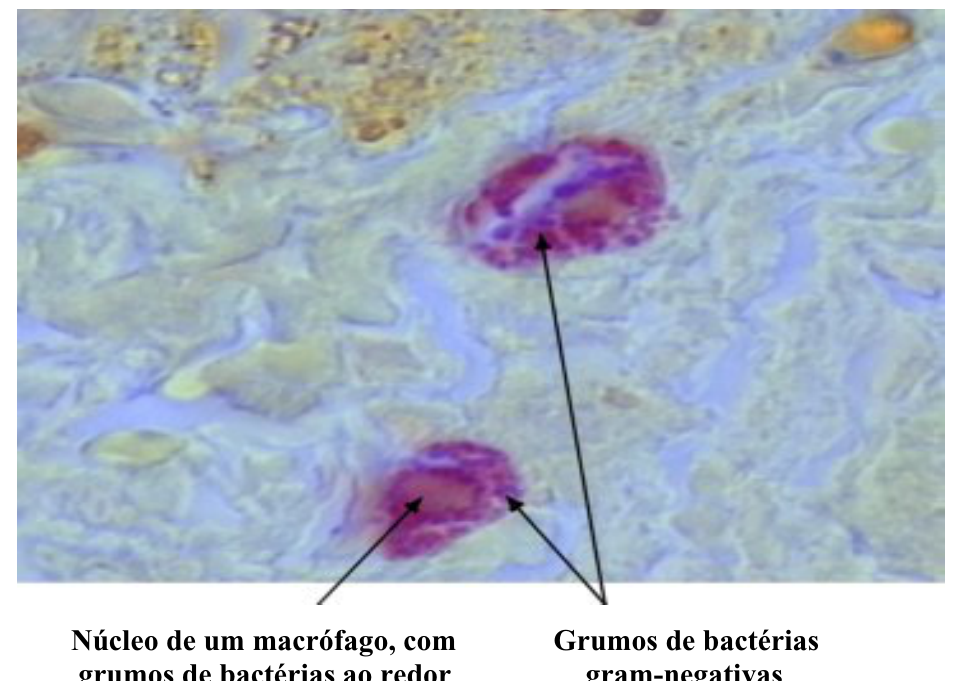
FIGURA 4 - Grumos de bactérias gram-negativas no citoplasma de macrófagos, ao redor de seu núcleo (Gram –